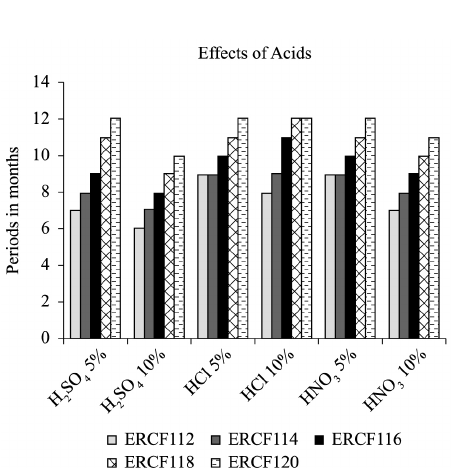
Figure 4. Graph of effects of Acids in epoxidized resole resin.